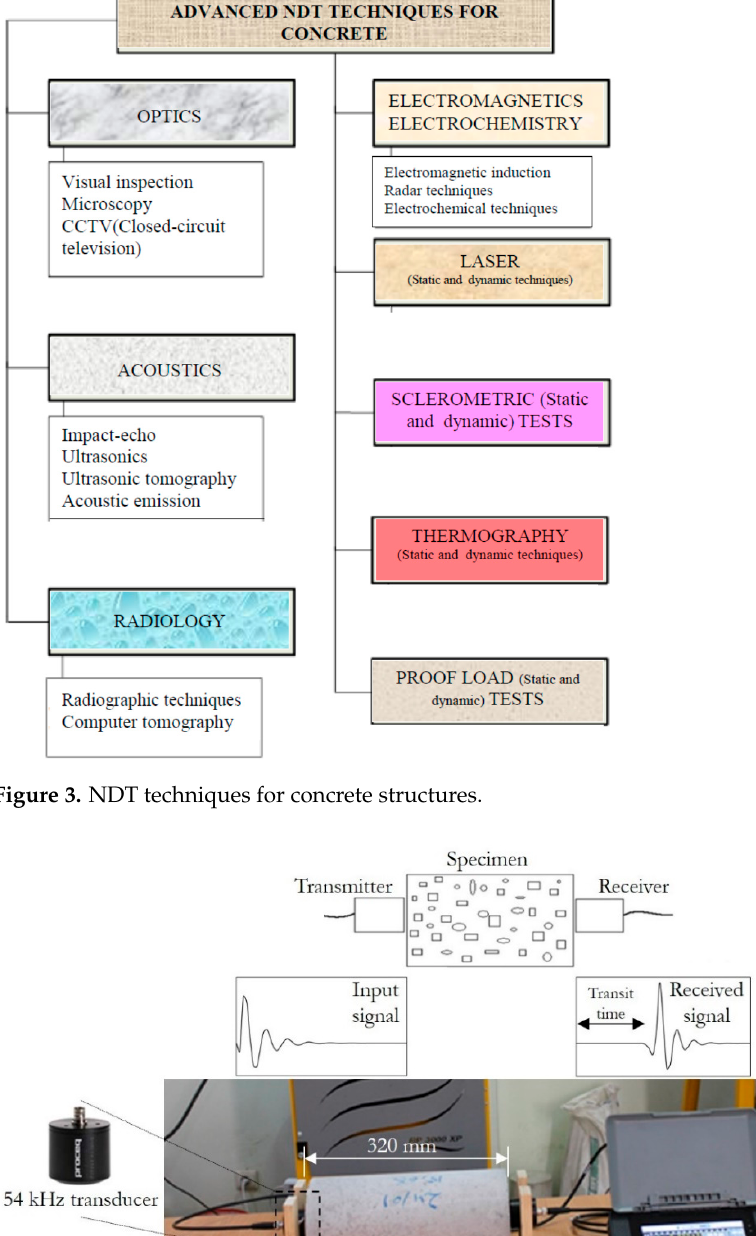
Figure 4. Experimental set-up: ultrasonic non-destructive testing (NDT).